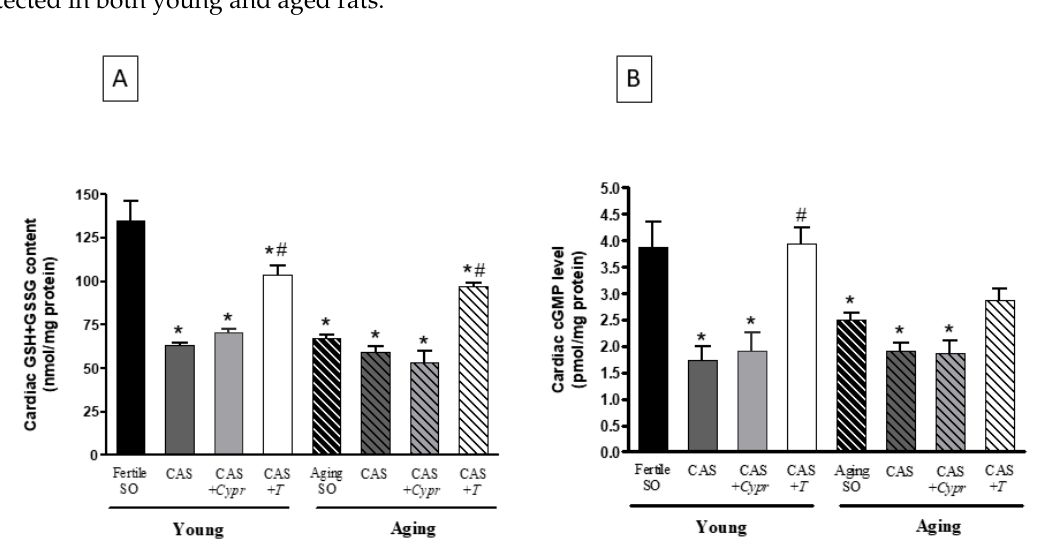
Figure 3. ( A ) The e ff ects of aging, surgical castration, and testosterone replacement therapy on the ratio of the reduced / oxidized glutathione content (GSH + GSSG; expressed as nmol / mg protein). The results are shown as the means ± S.E.M. n = 8–9. ( B ) The e ff ects of aging, surgical castration, and testosterone replacement therapy on the cardiac cyclic guanosine monophosphate level (cGMP; expressed as nmol / mg protein). The results are shown as the means ± S.E.M. n = 8–9. * p < 0.05: Statistical significance relative to the Young / SO fertile group, # p < 0.05: Statistical significance between age-matched CAS and CAS + T groups, CAS = surgical castration, T = testosterone replacement therapy, Cypr = cyproterone acetate treatment, and SO = sham operation.